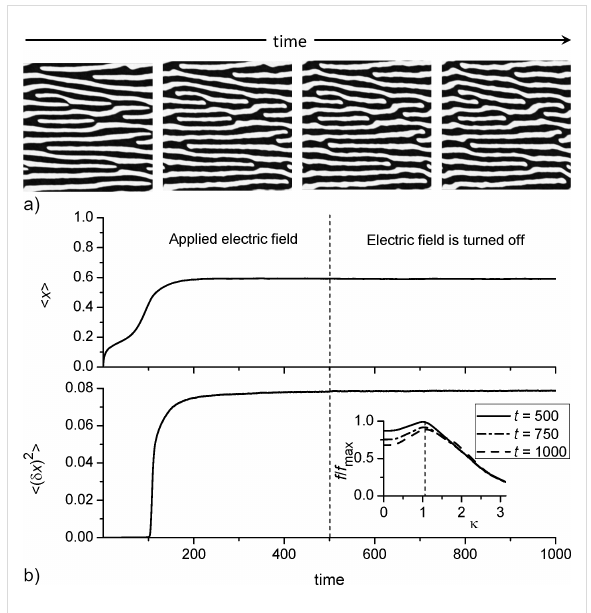
Figure 9: (a) Typical snapshots of the system evolution after the elec- tric field is turned off at k ∥ = 0.1, α = 0.06. The first snapshot corre- sponds to the case D em = 6. (b) Evolution of the mean adsorbate con- centration ⟨ x ⟩ (top panel) and the dispersion ⟨ ( δ x ) 2 ⟩ (bottom panel). The inset in Figure 9b shows the power spectral density function for the different times of deposition after the electric field is turned off.